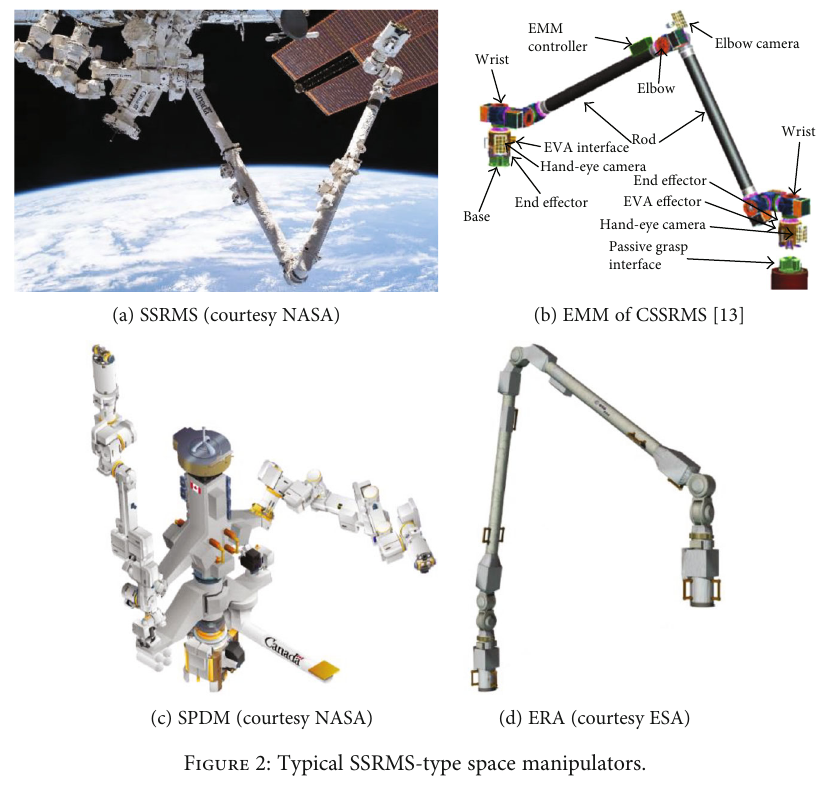
Figure 2: Typical SSRMS-type space manipulators.